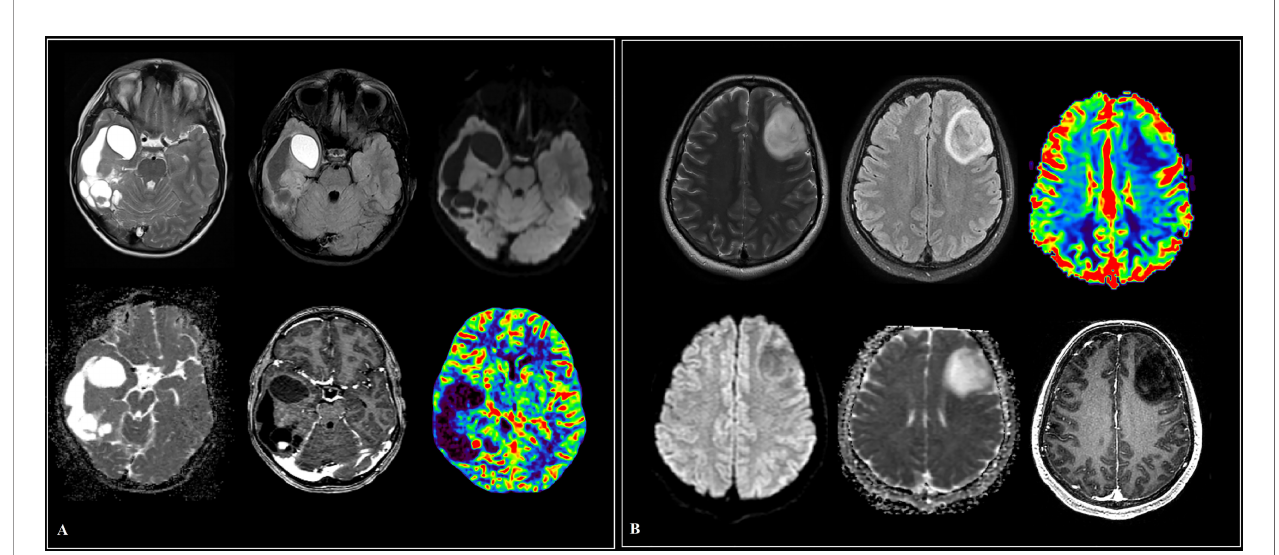
FIGURE 1 | Cases of low-grade glioma patients (A, B) . (A) A large intracerebral tumor of the right temporo-occipital areas with a heterogeneous cystic-solid structure, contrasted as a group of nodules and small closed rings in the solid part. The contents of the cysts are similar to the cerebrospinal fl uid in terms of signal characteristics, with the exception of a cyst in the pole of the temporal lobe, where a protein admixture and traces of hemorrhage are detected, the walls of the cysts do not increase. Diffusion restriction in the structure of education is not determined. In the posterior sections, a node with elevated median cerebral blood volume (CBV) values according to multi-slice computed tomography (MSCT) perfusion. (B) Predominantly in the middle frontal gyrus of the left frontal lobe, an intracerebral mass with diffuse distribution, clear contours and a sign of T2/ fl uid attenuation inversion recovery (FLAIR) mismatch. The tumor involves white and gray matter with “ swelling ” of the cortical plate. There is no restriction of diffusion, contrasting in the formation. Reliable areas of hyperperfusion according to dynamic susceptibility contrast (DSC) MR perfusion are not determined.